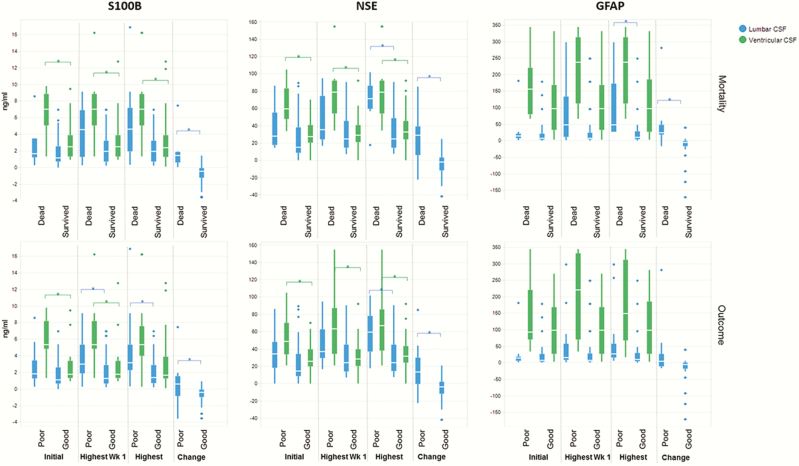
Univariate analysis between outcome and neuromarker indices. These box and whisker plots demonstrate the median, interquartile range, and range of various neuromarker indices (initial/admission concentration, highest concentration in week 1, highest concentration overall during hospitalization and the change between week 2 and admission) in association with mortality (top panel) and dichotomized clinical outcome (bottom panel, pediatric cerebral performance category scale [PCPS] 1–3: normal to mild/moderate disability = good outcome; PCSP 4–6: severe disability or death = poor outcome). Statistically significant results are indicated by a square bracket and *. Abbreviations: CSF, cerebrospinal fluid; GFAP, glial fibrillary acidic protein; NSE, neuron-specific enolase.